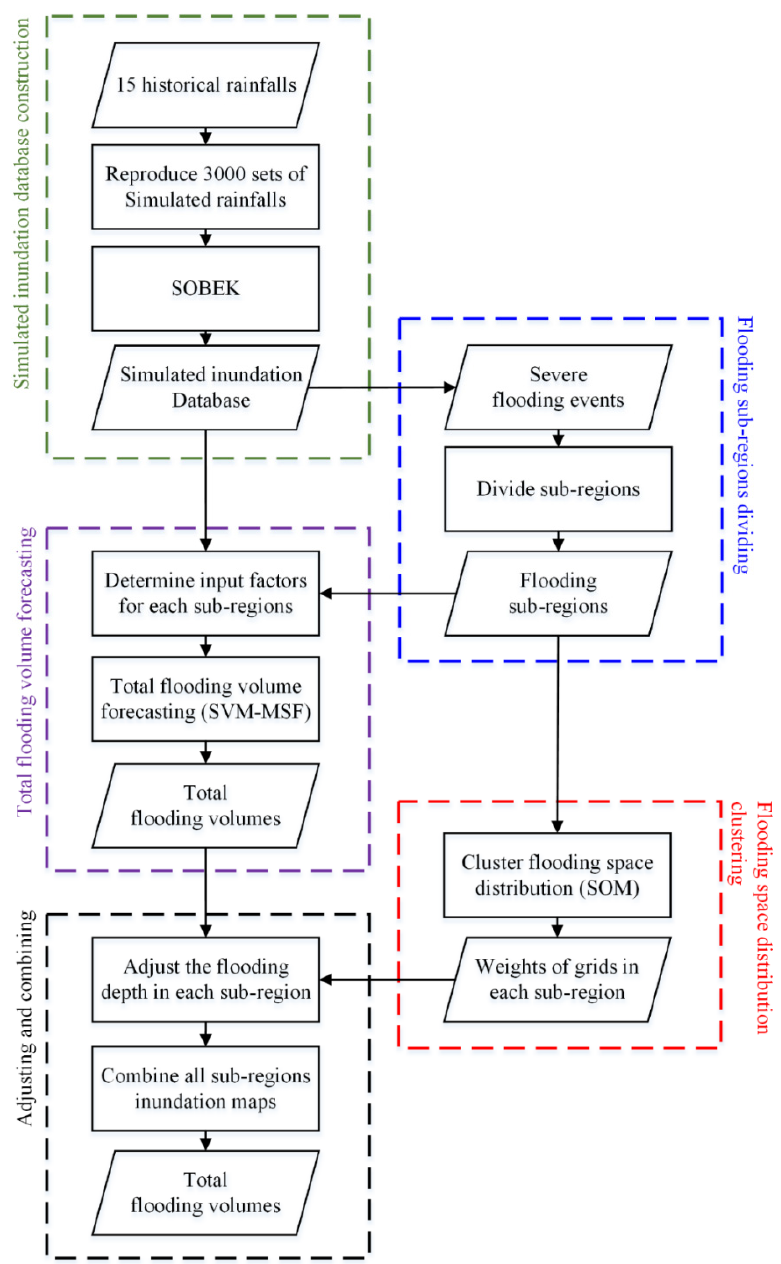
Figure 2. Flowchart of research.